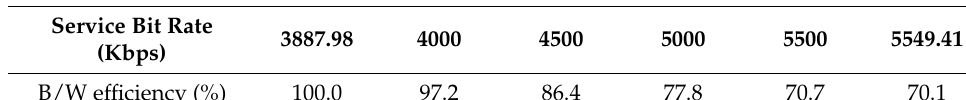
Figure 5. Simulation results of ‘of Forests and Men’. Table 5. Simulation results of ‘of Forest and Men’.